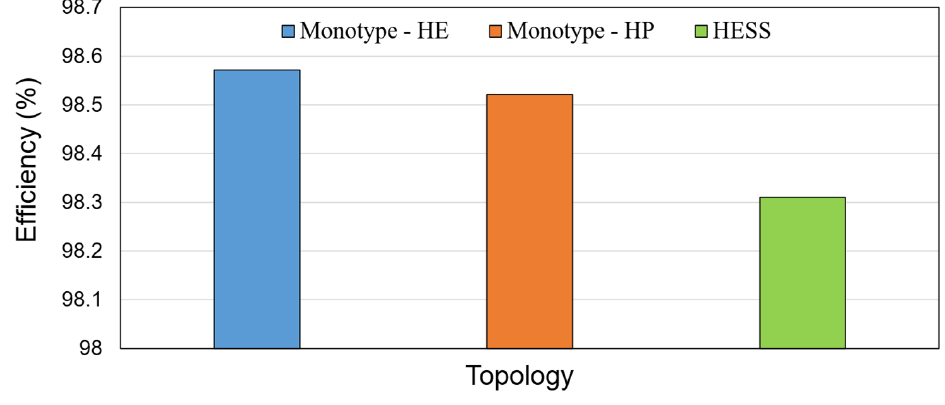
Figure 11. Battery system